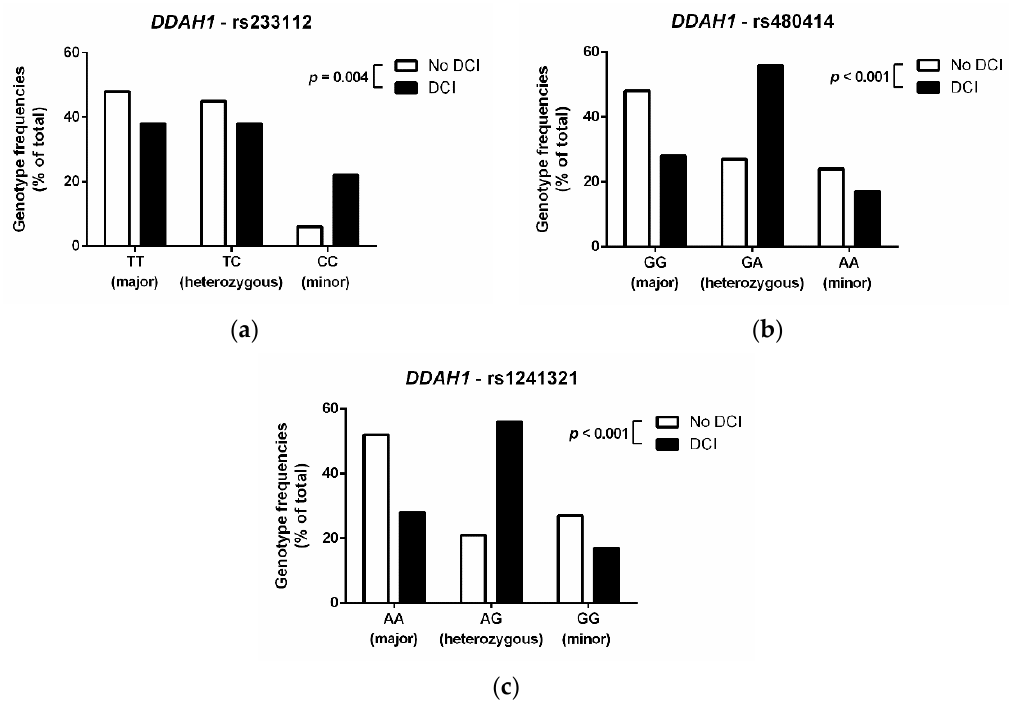
Figure 5. Frequency distribution of genotypes for ( a ) DDAH1 SNP rs233112, ( b ) DDAH1 SNP rs480414, and ( c ) DDAH1 SNP rs1241321 in SAH patients with or without DCI. For all three SNPs, the minor allele was more frequently observed in patients with DCI than in those without ( p values as indicated in the graphs). Abbreviations: DDAH1, dimethylarginine dimethylaminohydrolase 1; DCI,